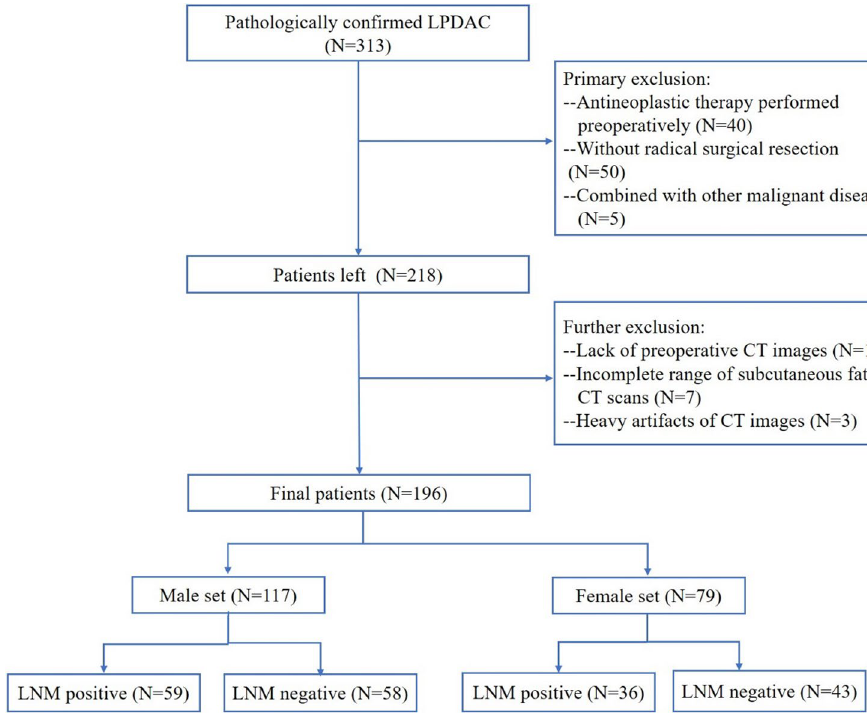
Fig. 1 Patient flowchart for this study. LPDAC